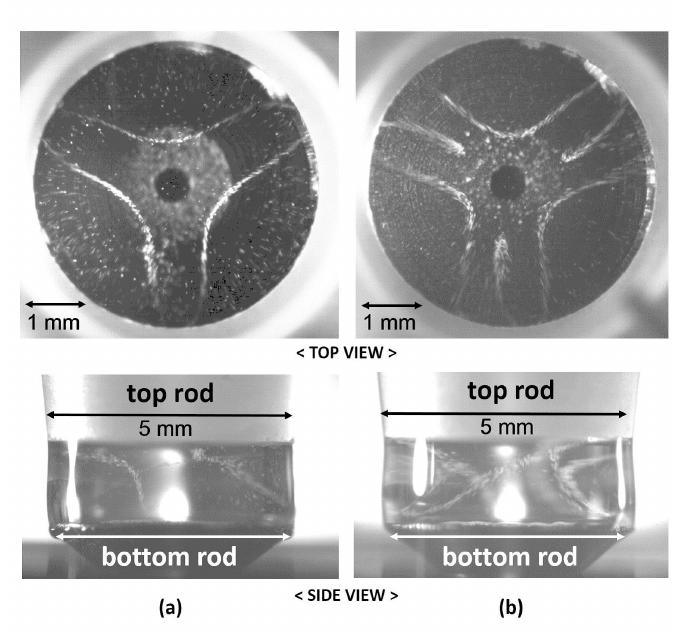
Figure 1. Snapshots of particle accumulation as viewed from above (top row) and from the side (bottom row) in a liquid bridge of Pr = 28.6, Γ = 0.68 ( R = 2.5mm), and V / V 0 = 1.0: ( a ) spiral loop (SL)1-particle accumulation structures (PAS) under Ma = 4.7 × 10 4 and ( b ) SL2-PAS under Ma = 5.8 × 10 4 . The direction of the PAS rotation or the travelling-wave-type oscillatory convection by the hydrothermal wave instability is counterclockwise for both cases in the top row, and is from right to left in the bottom row. Note that Ma is evaluated by applying H for the characteristic length L . (Figure 2 in Toyama et al.